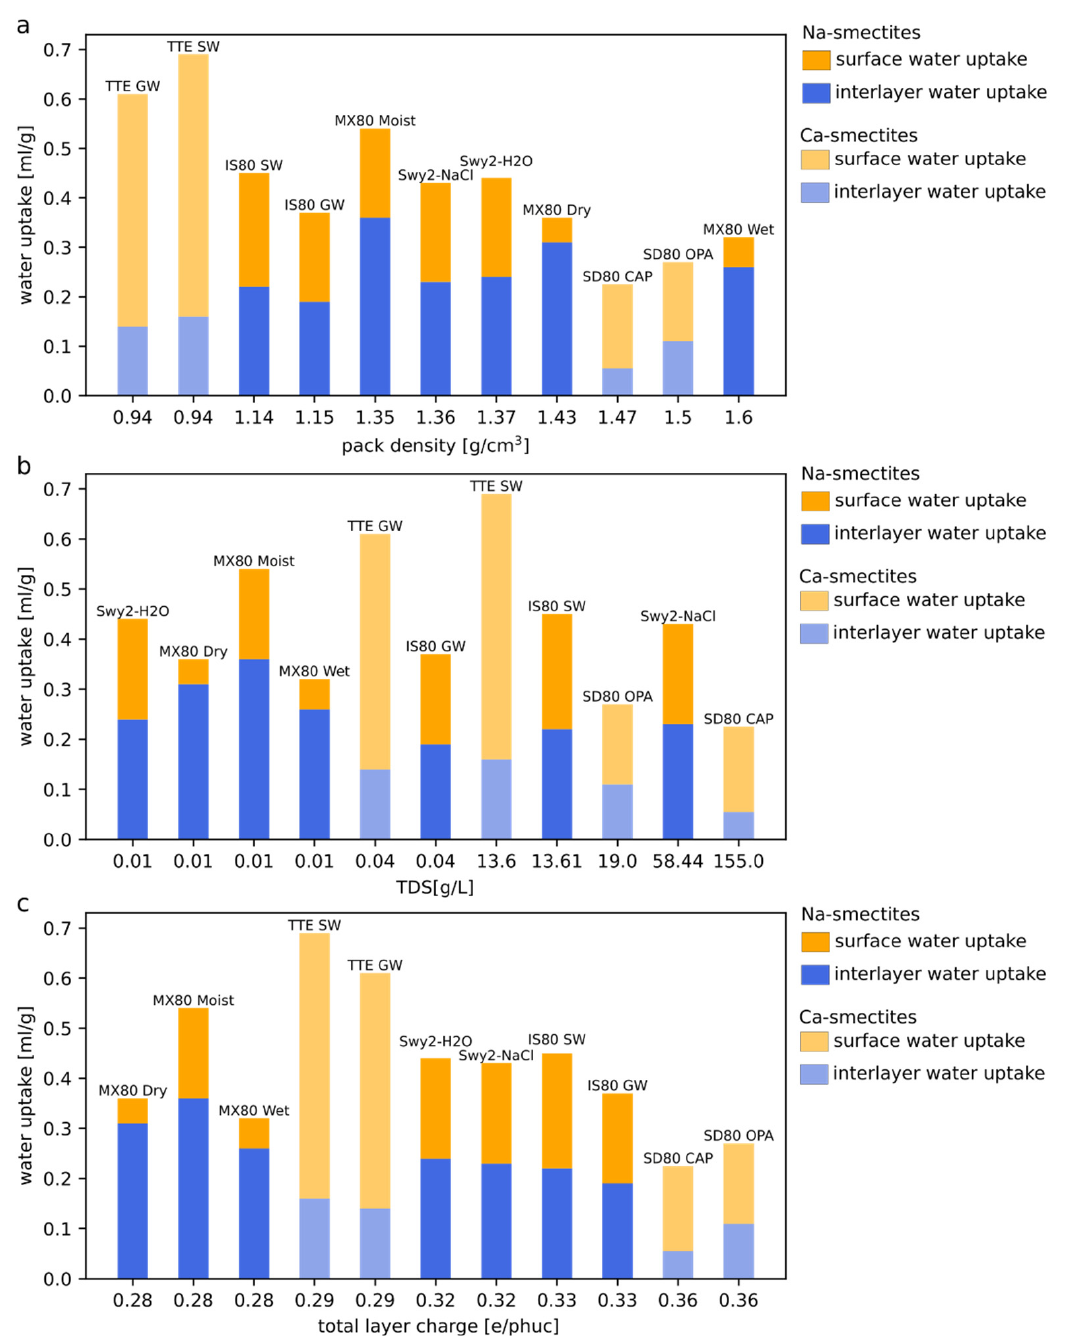
Figure 6. Summary of the amounts of interlayer and non-interlayer water in hydrated bentonite samples studied by wet-cell X-ray diffractometry [9,22,30]. ( a ) water uptake verses packing density, ( b )water uptake verses total dissolved solids (TDS), ( c ) water uptake verse total layer charge.